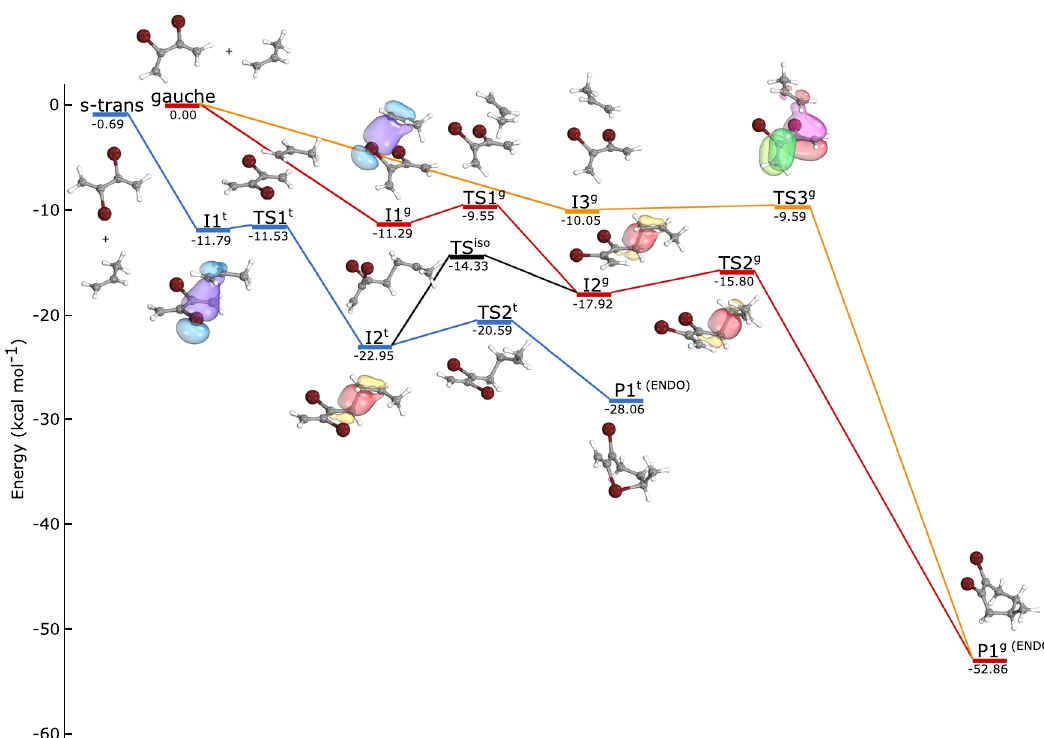
Fig. 4 Potential-energy surface of the reaction. Simpli fi ed zero-point-corrected potential-energy pro fi le of the electronic ground state of the [DBB-C3H6] + system showing the most important structures along the minimum-energy paths for the polar cycloadditions of both conformers of DBB calculated using the M06-2X density functional and the def2-TZVPP basis set (Methods). A detailed PES containing additional conformational pathways and side-products is shown in Supplementary Fig. 5. Selected molecular orbitals that illustrate chemical bonds formed during the reaction are depicted for speci fi c